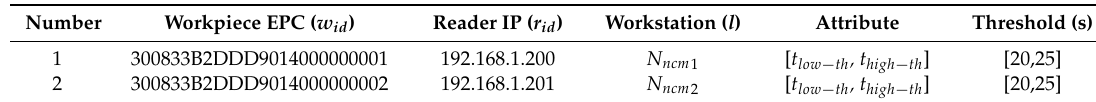
Table 6. Parameters of physical experiment.